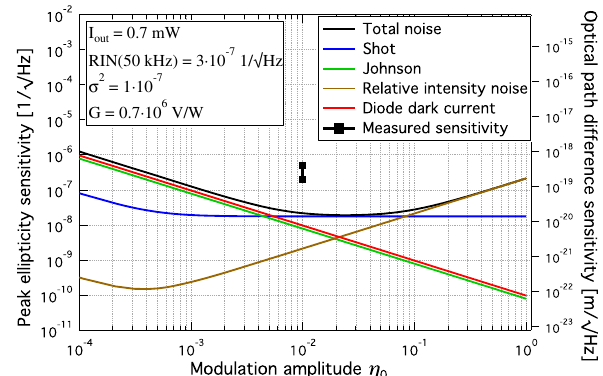
Fig. 2 Noise budget of the principal noise sources as a function of the modulation amplitude η 0 for the PVLAS polarimeter. A minimum which coincides with shot-noise sensitivity exists. Superimposed on the plot is the experimental sensitivity between 10 and 20 Hz with η = 10 − 0